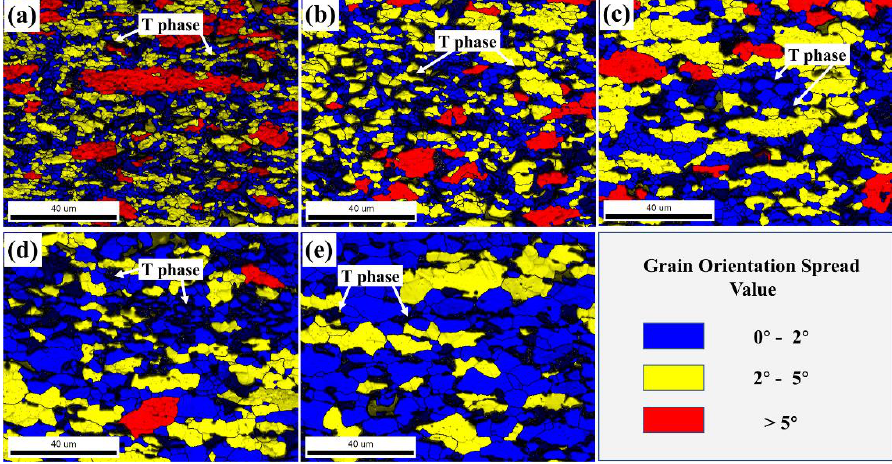
Figure 9. The GOS maps of the 13Zn alloy deformed to a 0.69 true strain at different temperatures with a strain rate of 0.1 s – 1 : ( a ) 300 °C; ( b ) 330 °C; ( c ) 360 °C; ( d ) 390 °C; ( e ) 420 °C.